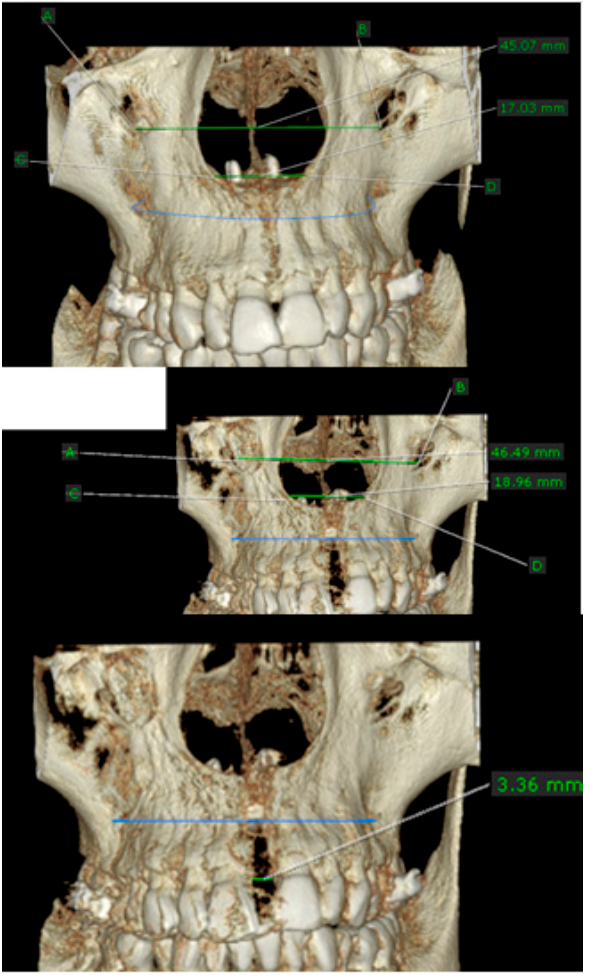
Figure 10. Cone Beam Computed Tomography CBCT images used in the study showing different measurements before and after the treatment: A: most mesial point of the infraorbital foramen right side; B: most mesial point of the infraorbital foramen left side; C: most lateral point of the nasal notch right side; D: most lateral point of the nasal notch left